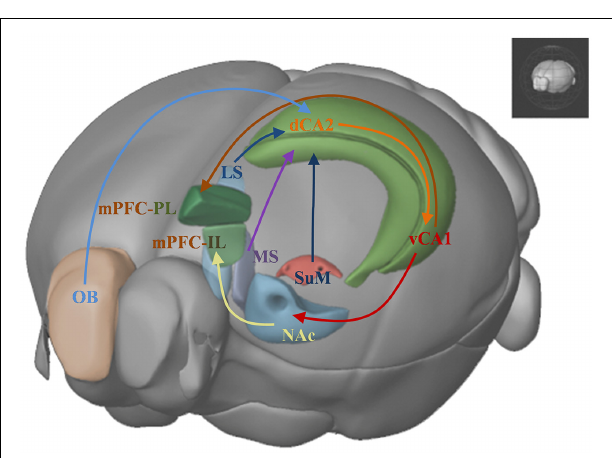
FIGURE 3 | Brain networks underlying social recognition memory. OB: olfactory bulb; dHPC: dorsal hippocampus; dCA2: dorsal CA2; LS: lateral srptum; MS: medial septum; SuM: supramammillary nucleus; vCA1: ventral CA1; NAc: nucleus accumbens; IL: infralimbic area; PL: prelimbic area; mPFC: medial prefrontal